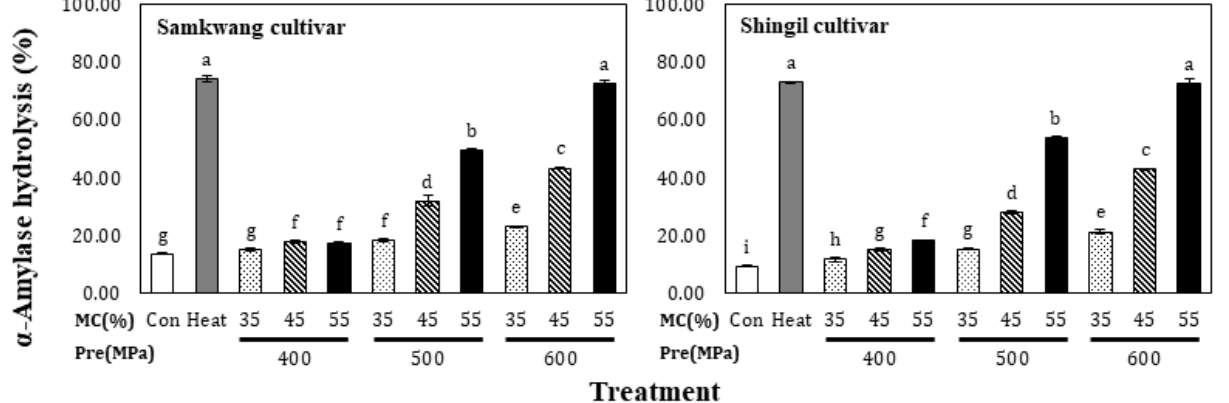
Figure 6. α -Amylase hydrolysis of high hydrostatic pressure-treated rice flour at different moisture levels. Con: Control, Heat: Heat treatment, MC: Moisture content of rice flour. Different small letters in the same items indicate a significant difference as determined by Duncan’s range test ( p < 0.05), according to the treatment method. 3.6. Rapid Viscosity Analysis (RVA) The pasting properties of the HHP-treated rice flour are shown in Table 1. The peak viscosity, trough, and final viscosity of the Samkwang variety was the highest in the con- trol, at 237.83 ± 0.33, 141.13 ± 0.21, and 257.08 ± 0.42 RVU, respectively. For the Shingil variety, the values were 94.54 ± 0.38, 60.04 ± 0.04, and 136.67 ± 0.17 RVU, respectively. The setback was the highest in the Shingil variety, with 42.12 ± 0.12 RVU, and had a high